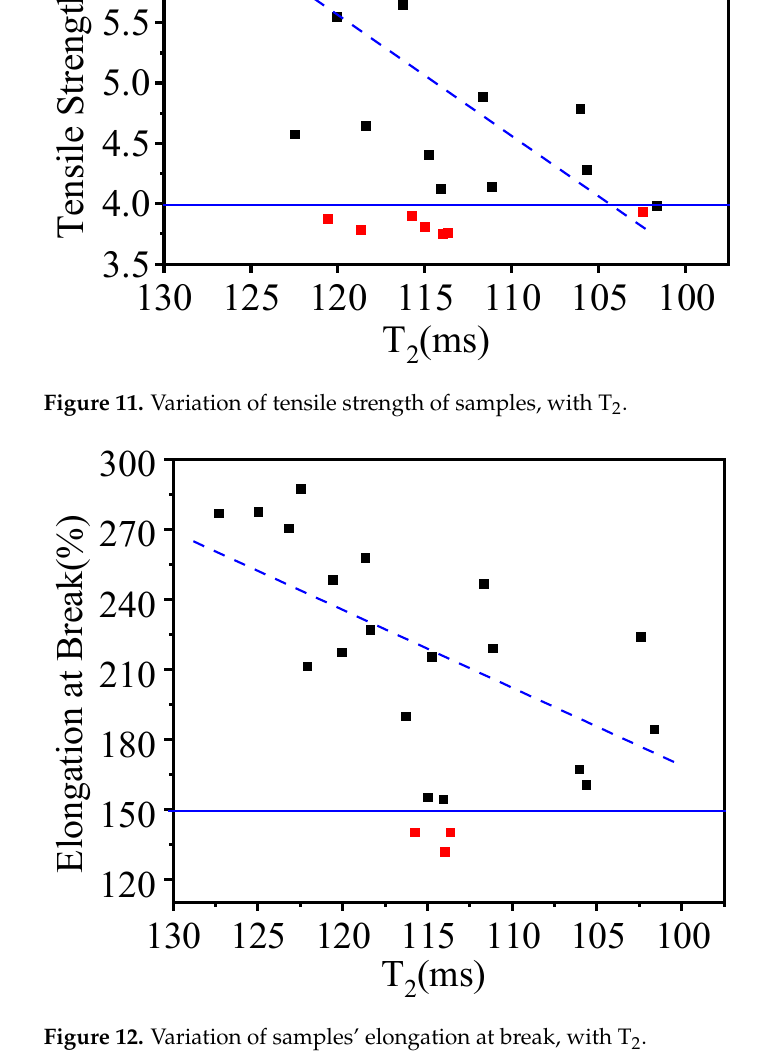
Figure 12. Variation of samples’ elongation at break, with T 2 .